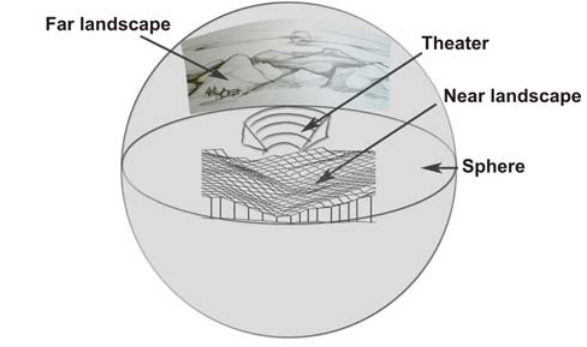
Figure 12. Structure of 3D environment